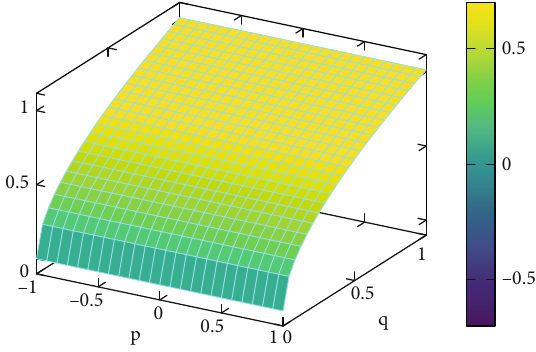
Figure 3: Wigner function for Gross-Pitaevskii model; n = 300 .